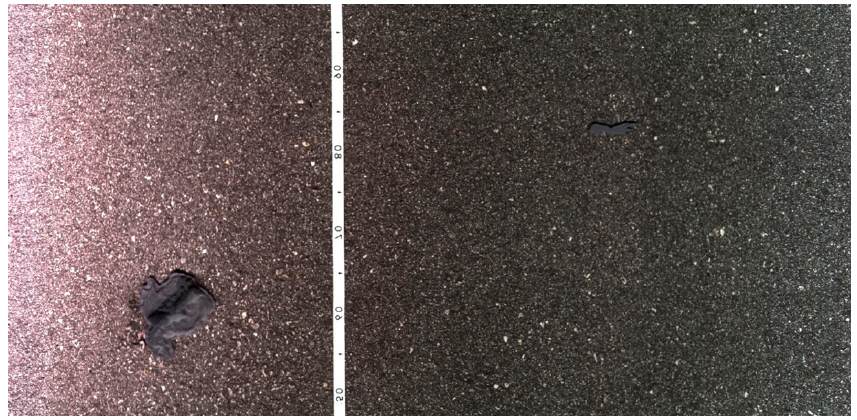
Figure 13. Scanned 3D model of amphibian casualties on asphalt, body part on the left and leg on the right. Sensors 2016 , 16 , 558